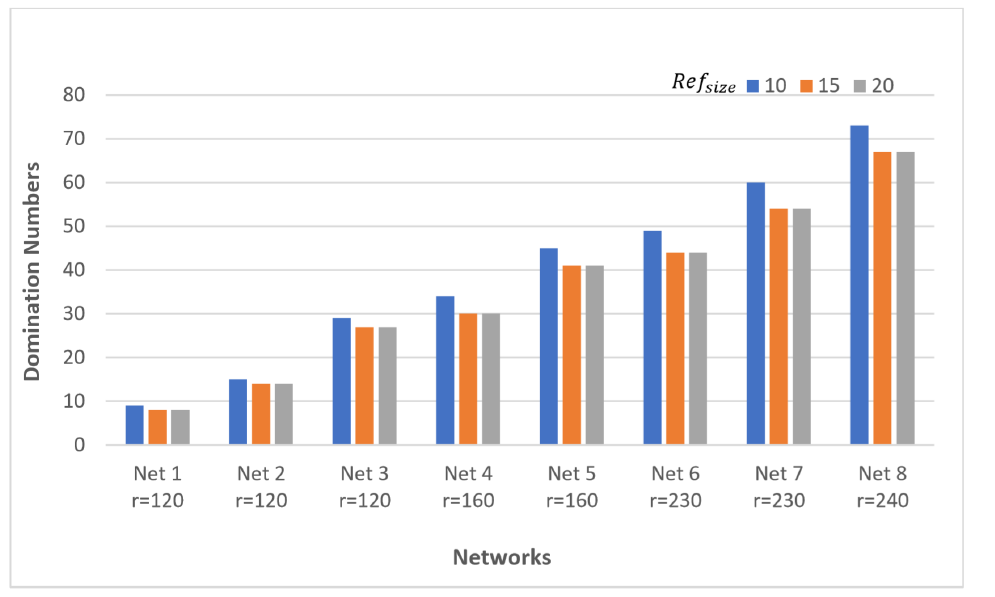
Figure 4. The performance of the ASS-MCDS with different Ref